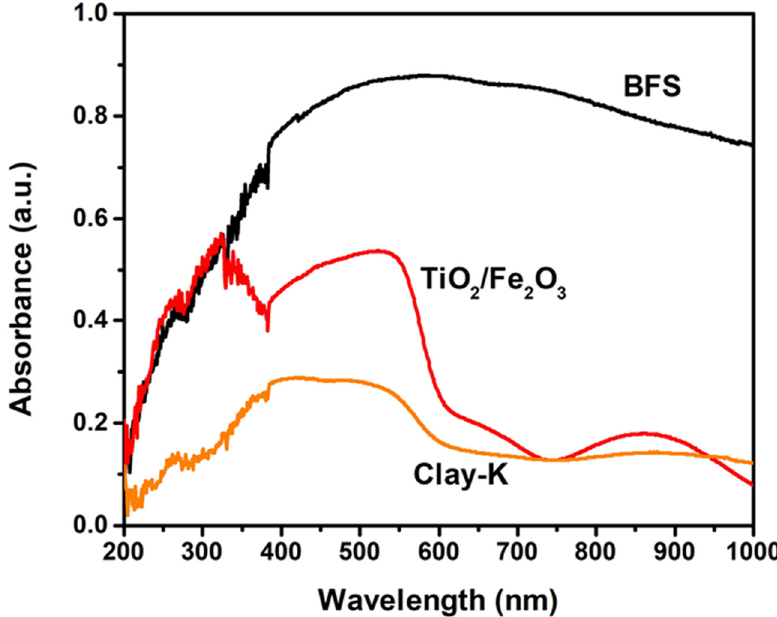
Figure 5. Absorption spectra of Clay-K, BFS, and TiO 2 /Fe 2 O 3 materials.